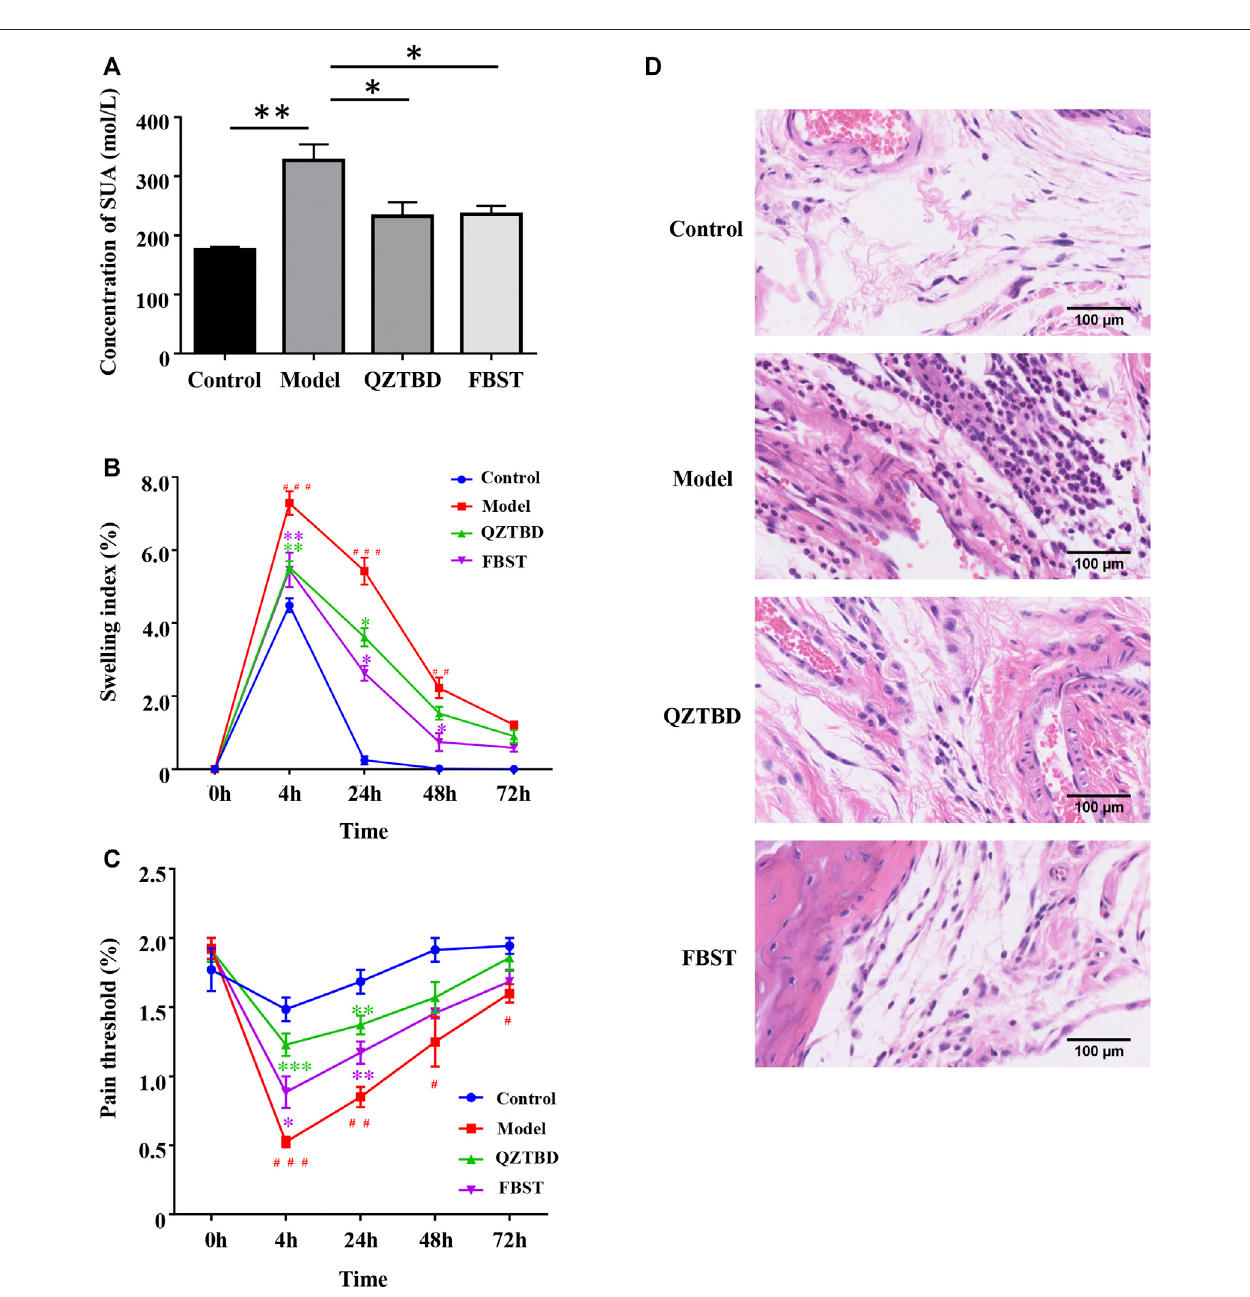
FIGURE2| QZTBDalleviatedgoutysymptomseffectively.EffectsofQZTBDonSUA (A) ,footpadswellingindex (B) ,footpadpainthreshold (C) ,andHEanalysisof the footpad (D) . “ # ” represents p < 0.05 in the comparison with the control group; “ # # ” represents p < 0.01 in the comparison with the control group and “ # # # ” represents p < 0.001 in the comparison with the control group; “ * ” represents p < 0.05 in the comparison with the model group; “ ** ” represents p < 0.01 in the comparison with the model group and “ *** ” represents p < 0.001 in the comparison with the model group. N (cid:2) 7/group.